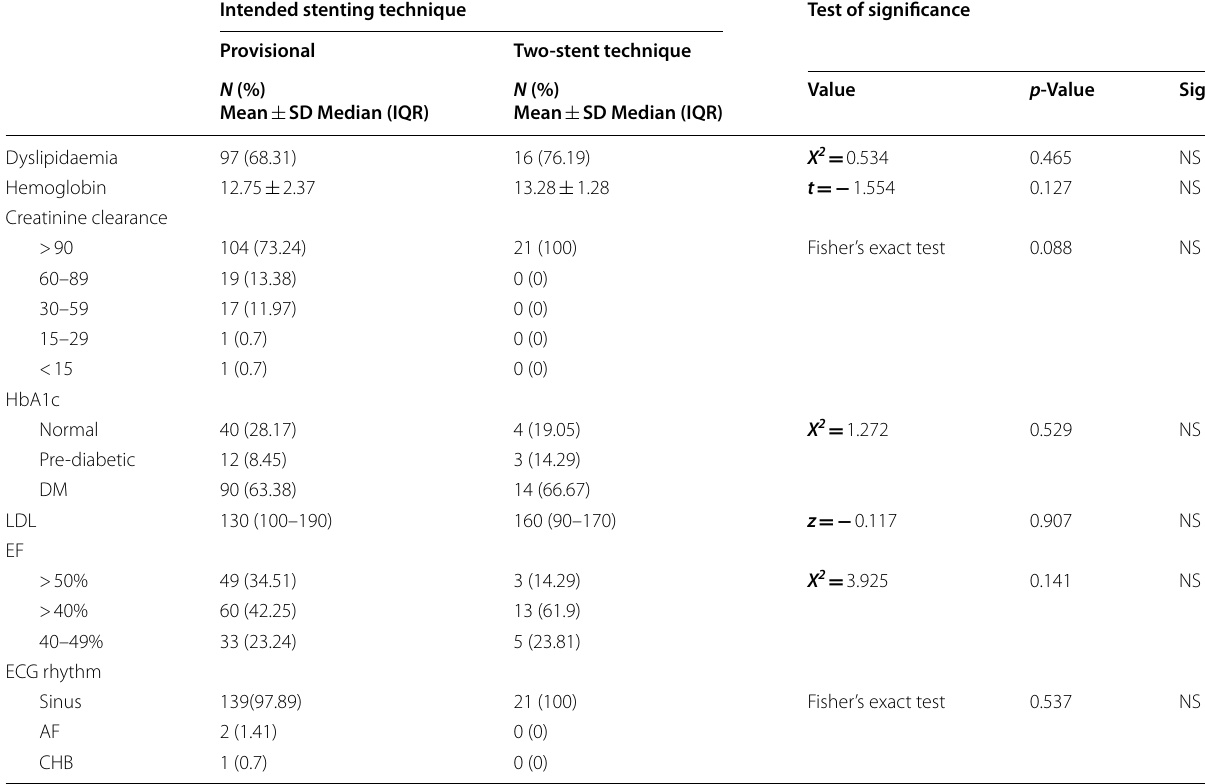
Table 2 Laboratory data, ECG and cardiac